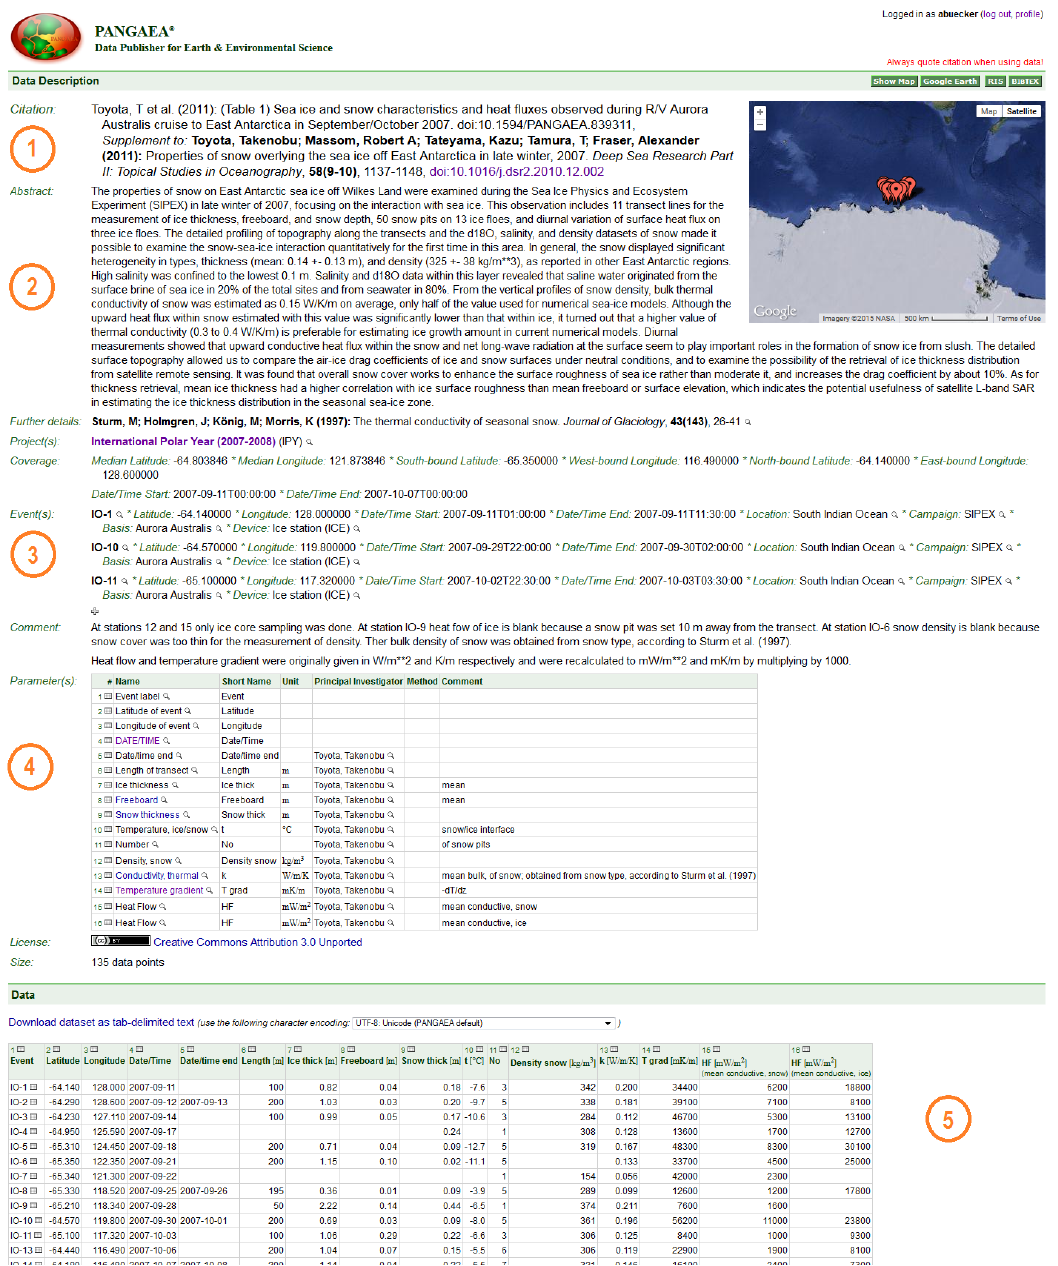
Figure 1. Example of an IPY data set in PANGAEA; metadata (upper part: 1 – citation; 2 – abstract; 3 – georeference; 4 – parameters, units, comments) are followed by the actual data (lower part: 5) (Toyota et al.,